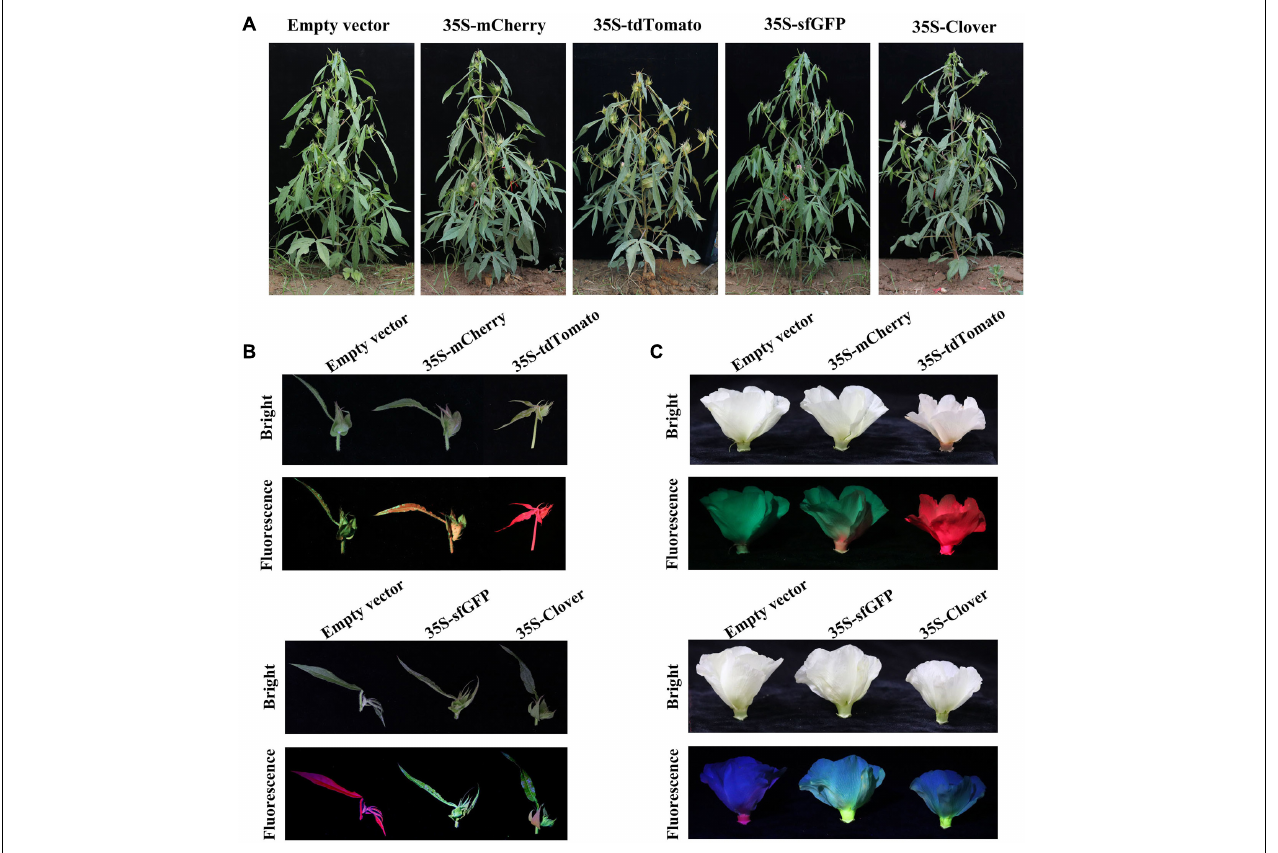
FIGURE 5 | The fluorescence of T 1 progeny in field conditions. (A) The morphology of empty-vector and green/red fluorescent protein (GFP/RFP, respectively)-expressing T 1 plants in field at the reproductive stage. (B) Young fruiting branches of empty-vector- and GFP/RFP-expressing T 1 plants growing in the field under white light (bright) and excitation light (fluorescence). (C) The flowers of empty-vector and GFP/RFP-expressing T 1 plants under white light (bright) and excitation light (fluorescence). GFPs: sfGFP and Clover; RFPs: mCherry and tdTomato.